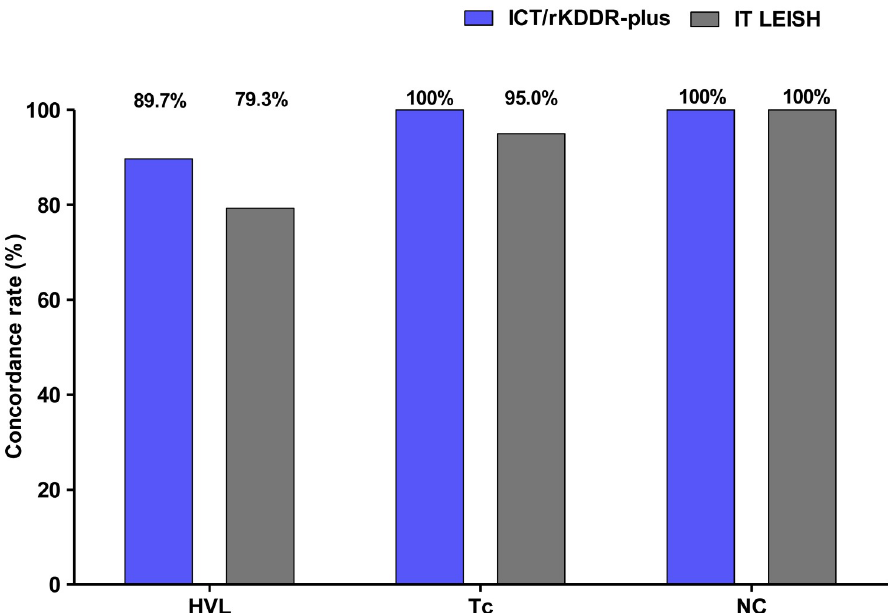
Fig 4. Concordance rate of the rapid immunochromatographic test results with reference standard for diagnosis of human visceral leishmaniasis (HVL) with the serum samples. The comparison of the performance between the rapid tests ICT/rKDDR-plus (Safetest Diagno´sticos) and IT LEISH (DiaMed AG) was performed using 69 human serum samples from patients infected with Leishmania (HVL, n = 29); patients chronically infected with T . cruzi (Tc, n = 20), to evaluate cross reactivity; and healthy individuals used as negative control (NC, n = 20). Reference test: